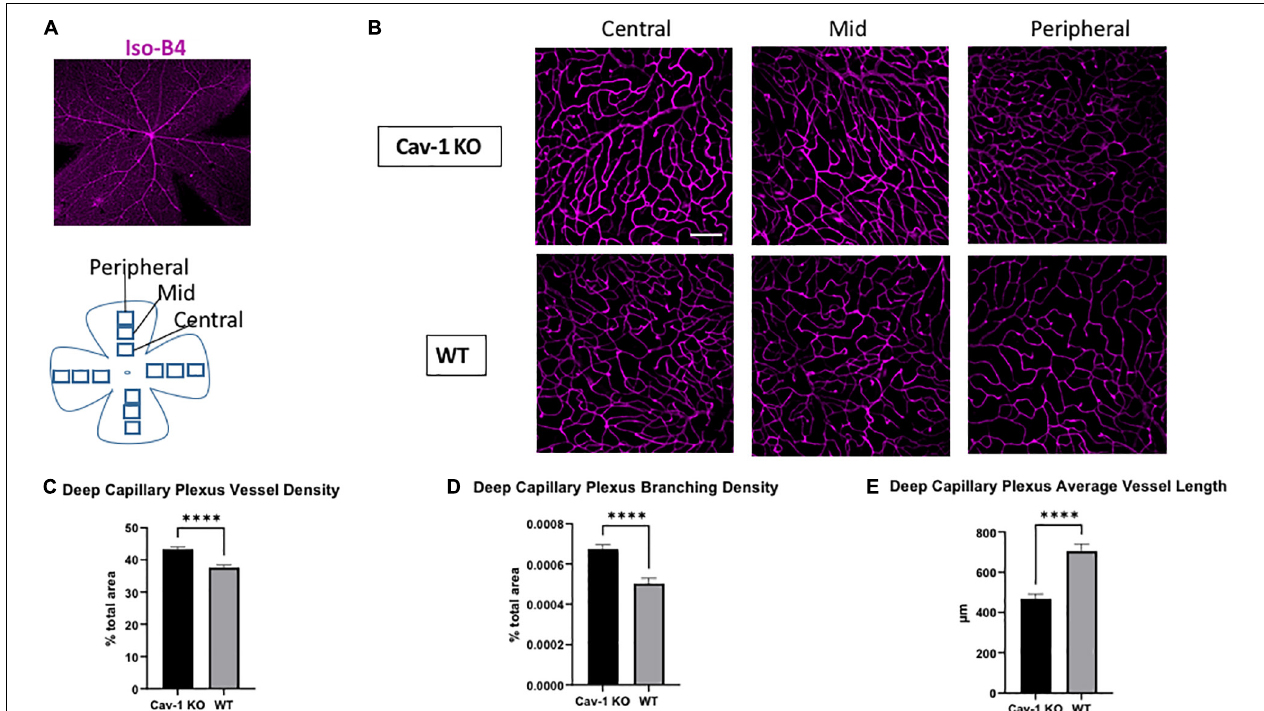
FIGURE 4 | Analysis of deep capillary plexus morphology. (A) Representative image of flat-mounted retina stained with endothelial cell marker Isolectin-B4 (Iso-B4, magenta). (B) Iso-B4 staining at various eccentricities from the optic nerve head in flatmounted retina, scale bar in white indicates 100 µ m. (C,D) Cav-1 KO mice show increased vessel density and branching density in the deep capillary plexus, compared to WT. (E) The average vessel length in the deep capillary plexus is shorter in Cav-1 KO compared to WT, **** p <